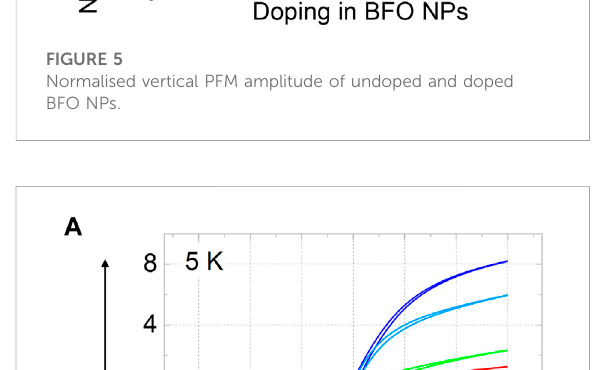
(Supplementary Figure S3A) are qualitatively different from those measured before (Figure 6). The hysteresis loops have a pronounced S-shape with a remanent magnetization of